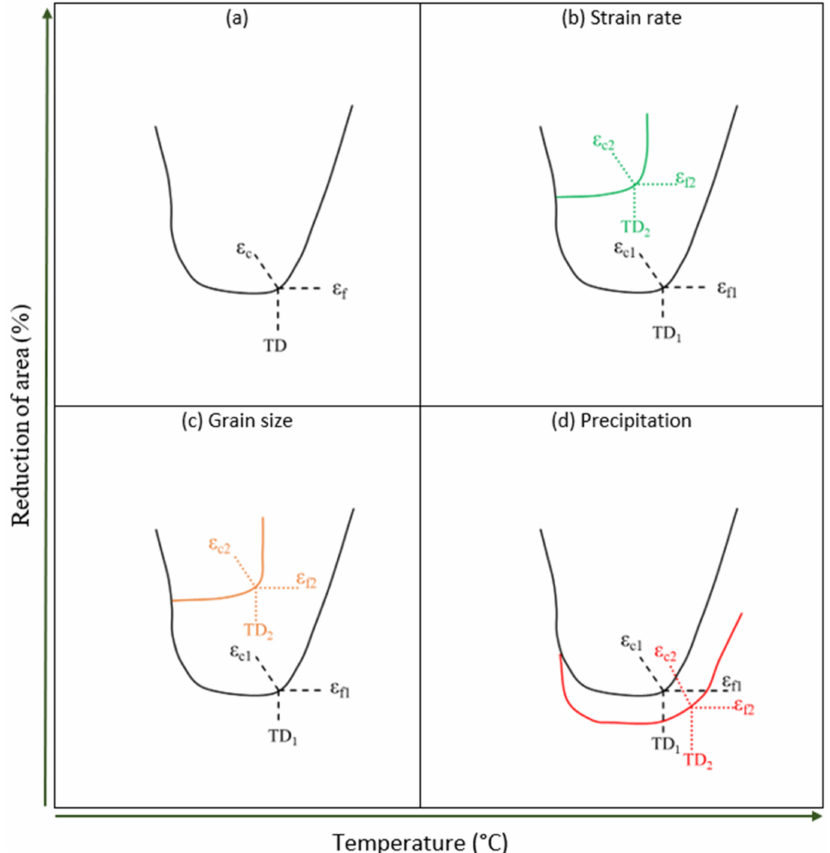
Figure 9. Schematic diagram showing ( a ) how the width of the ductility trough could be controlled by the dynamic recrystallization (DRX), ( b ) how increasing the strain rate reduces the depth and width of the trough where ε c1 , ε f1 and TD 1 refer to the lower strain rate. ε c2 , ε f2 and TD 2 refer to the higher strain rate ( c ) how refining the grain size reduces the depth and width of the trough, where ε ε ε ε c1 , c2 , f1 and TD 1 refer to the coarser grain size and f2 and TD 2 refer to the finer grain size and ( d ) the influence of precipitation in increasing depth and width of the trough where ε c1 , ε f1 and TD 1 refer to trough without precipitation and ε c2 , ε f2 and TD 2 , the trough with precipitation. TD is the temperature on cooling when the changeover occurs from DRX of